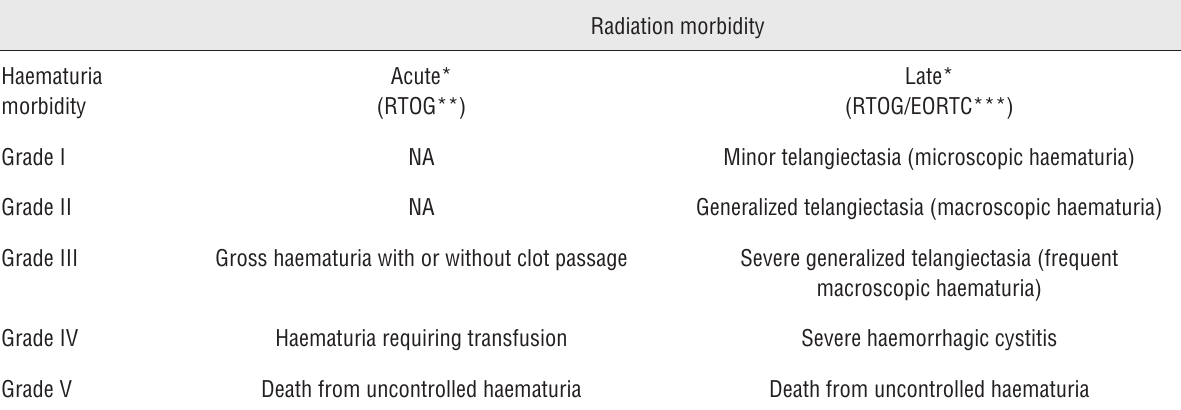
Table 1 - Classification of haematuria events for both acute and late radiation morbidity scoring criteria for radiation-induced haemorrhagic